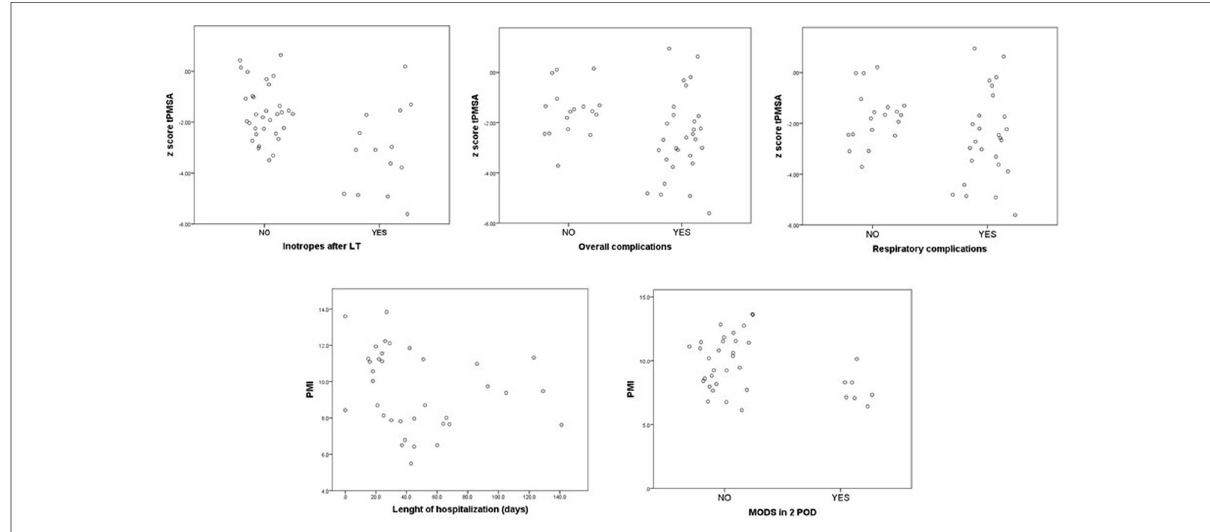
FIGURE 3 Correlations among z -score t-PMSA (1 – 16 years old) or PMI and outcomes after